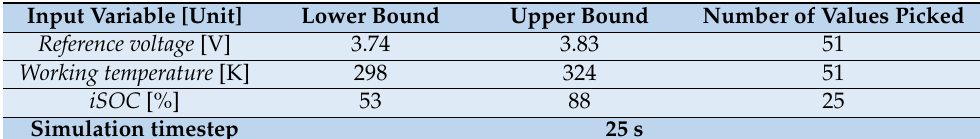
Table 3. Input variable observation